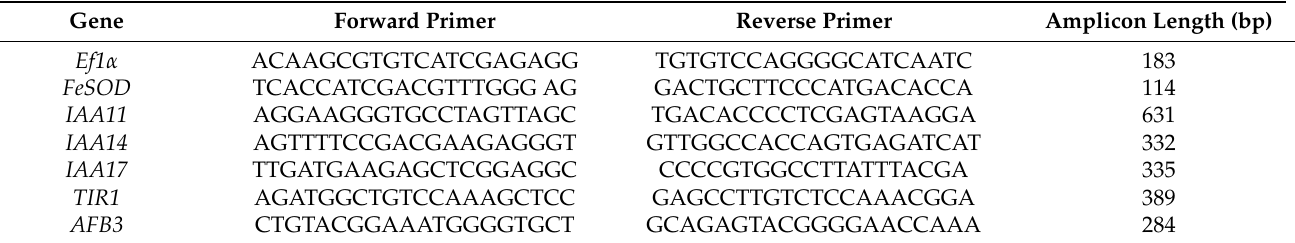
Table 3. Primers used for the gene expression